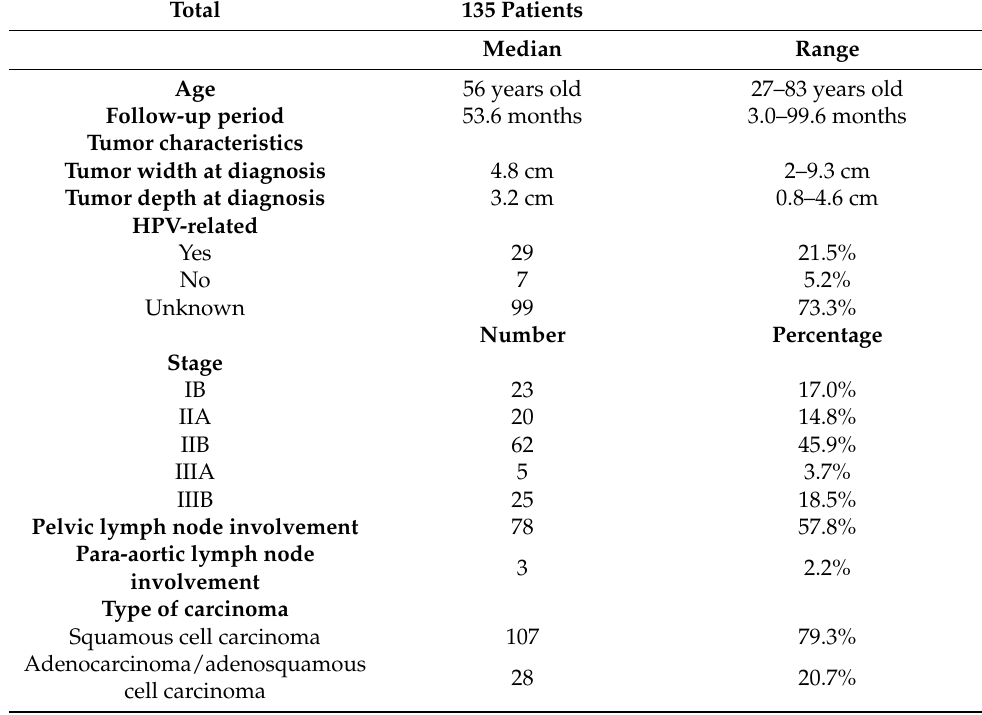
Table 1. Clinical characteristics of the participants.